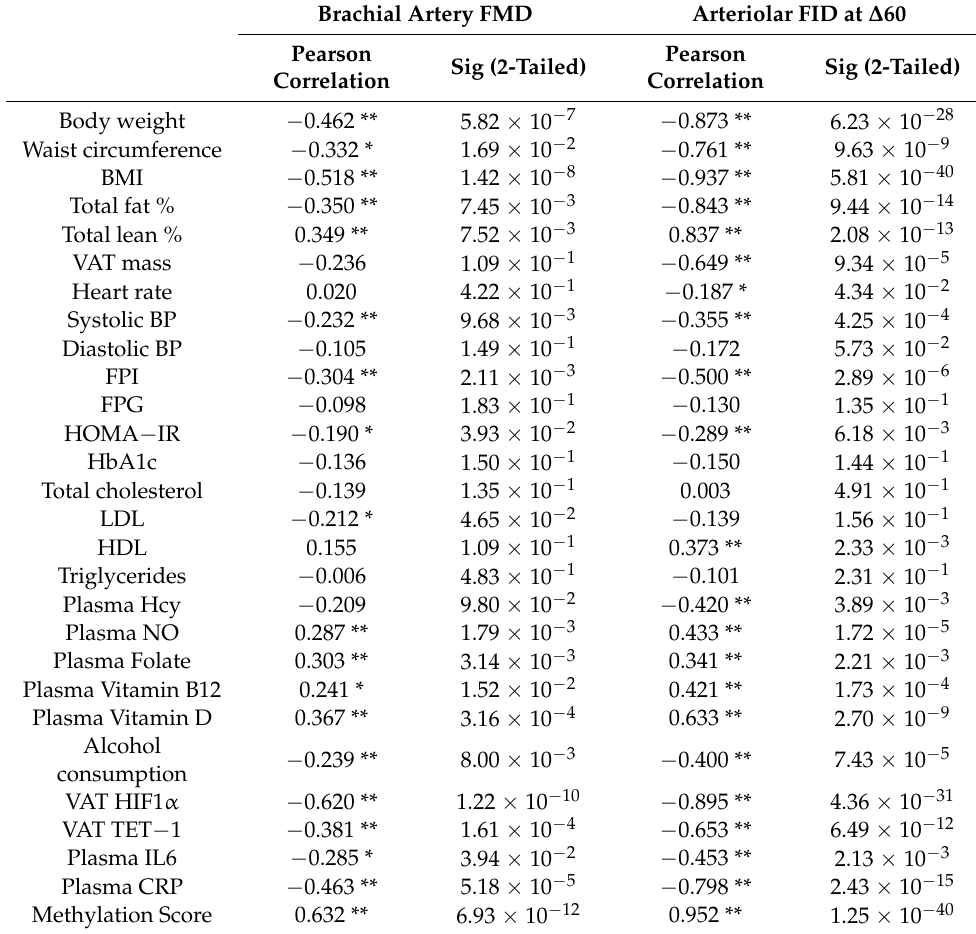
Table 6. Correlations between vascular reactivity and cardiometabolic risk